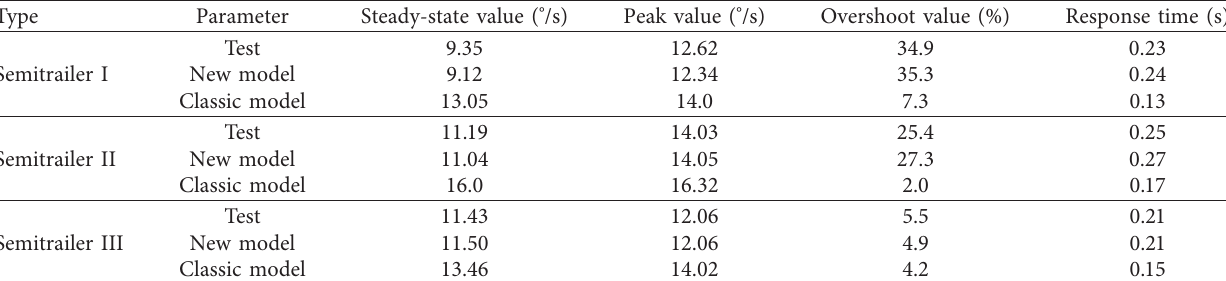
Figure 5: Experimental verification of the handling and stability for the semitrailer. Table 2: Comparison of the yaw rate for different tractor